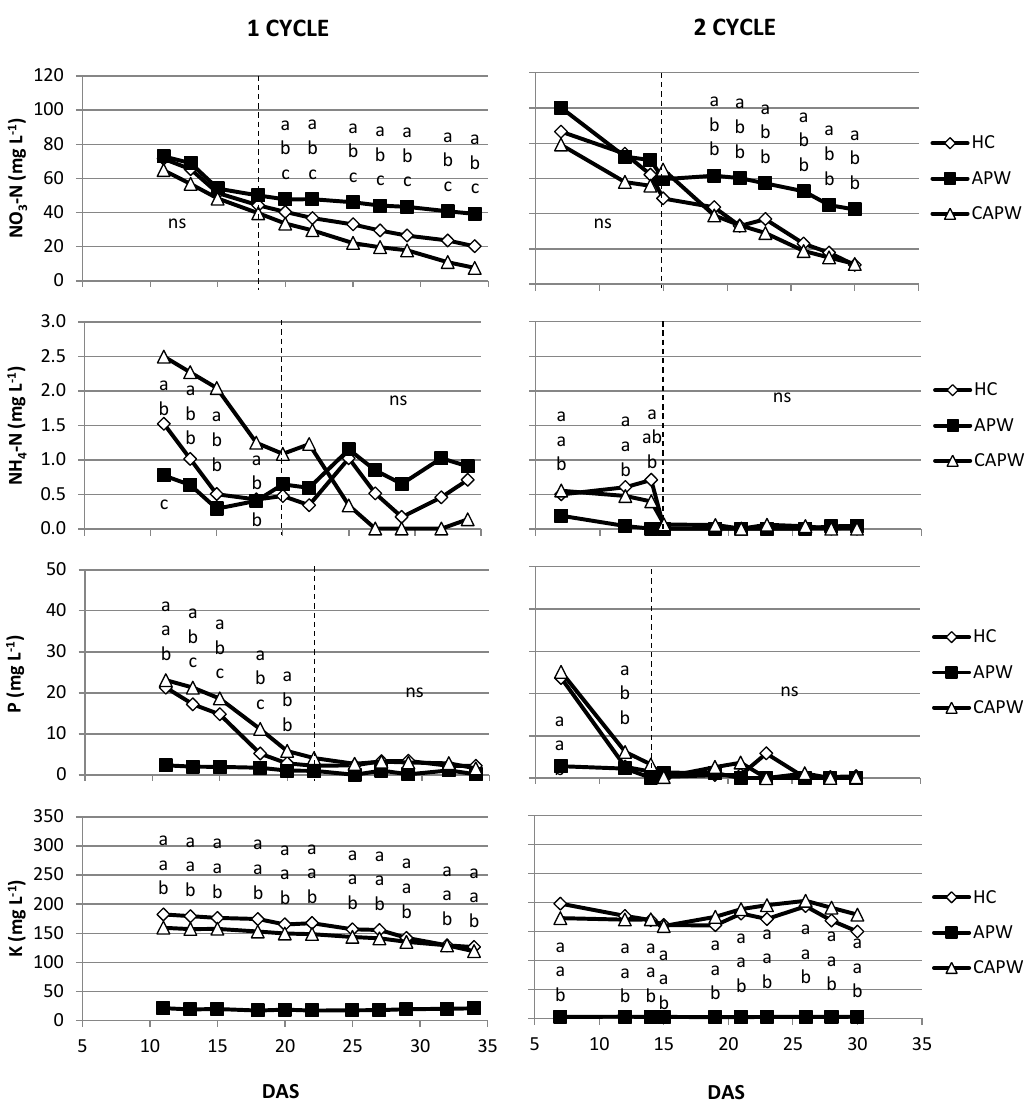
Figure 4. Effect of water treatment on nitrogen, phosphorus, and potassium concentrations during both growth cycles. Different letters on the same DAS indicate significant differences with p < 0.05, based on Tukey HSD Test. HC: hydroponic control; APW: aquaponic water; CAPW: complemented fish water.